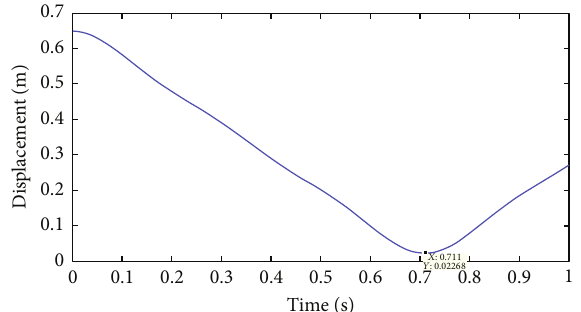
Figure 4: Displacement of the slurry unit at 𝑥 = 0 varies in one